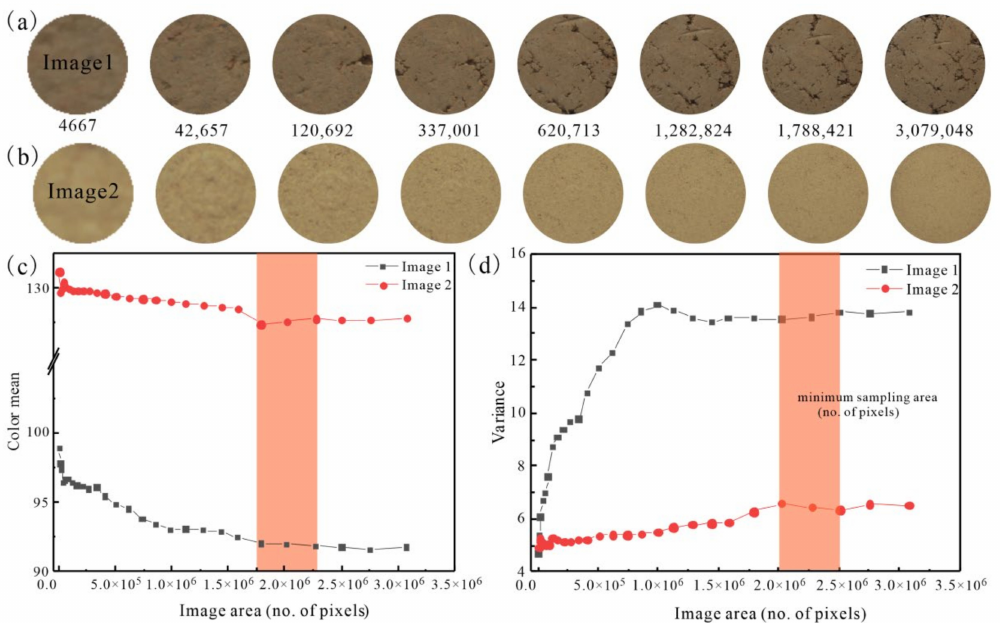
Figure 6. Color mean and variance of different sampling areas: ( a , b ) Image 1 and Image 2 with different sampling area respectively; ( c , d ) changes of mean and variance of color with sampling area change